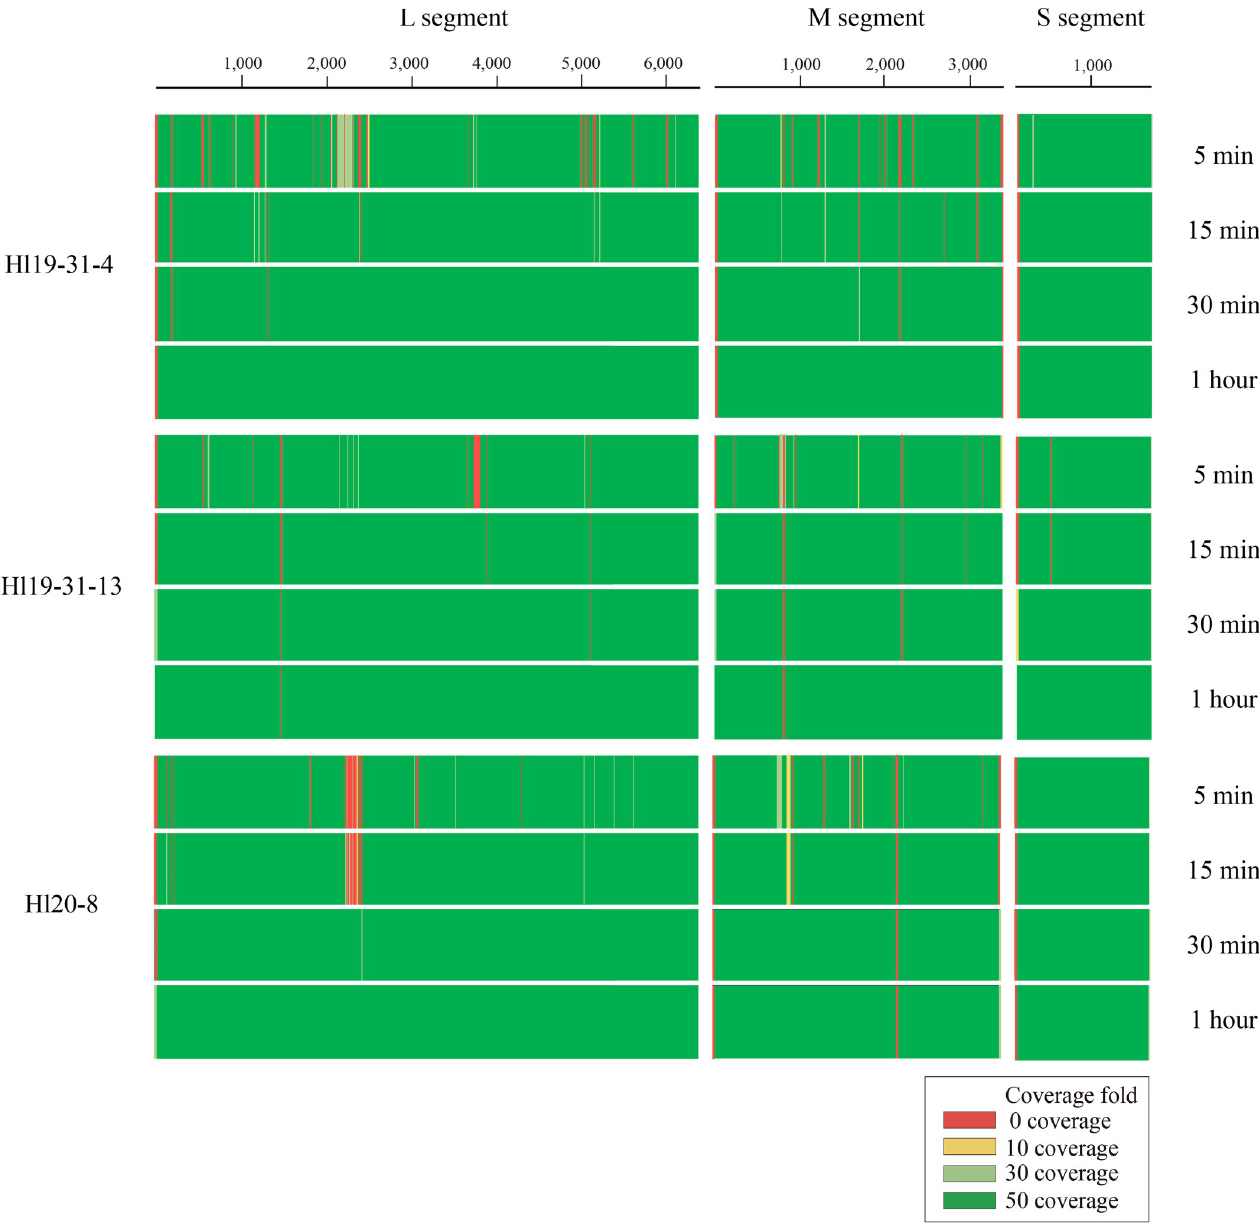
Fig 3. Average depth of coverages of severe fever with thrombocytopenia syndrome virus (SFTSV) L, M, and S segments using multiplex PCR-based nanopore sequencing at different cumulative running times. The average depth of coverages of SFTSV tripartite genomes was shown by using amplicon- based nanopore sequencing at 5 min, 15 min, 30 min, and 1 h. The colors represent the coverage fold; 0 coverage (red), from 1 to 10 coverage (yellow), from 11 to 30 coverage (light green), from 31 to 50 and over 50 (green).